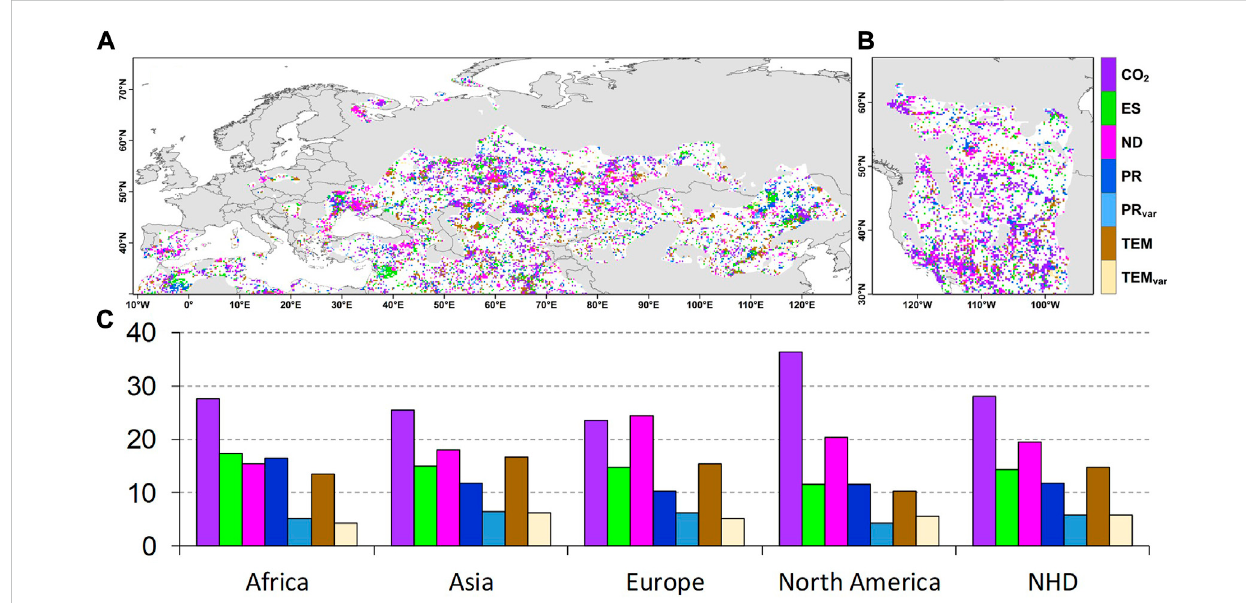
FIGURE 3 Maindriversofthesigni fi canttrends(Mann-Kendall, p < 0.05)inthevegetation-soilmoisturesensitivityperpixel. (A,B) Thespatialdistributionofthe drivers of the vegetation-soil moisture sensitivity in the Northern Hemisphere drylands (NHD). (C) The area fractions of the lands that are dominated by each factor (%). Abbreviations: CO 2 , ES, ND, PR, PR var , TEM, and TEM var are the CO 2 concentration, ecosystem structure, nitrogen deposition, precipitation, variation in precipitation, air temperature, and variation in air temperature,